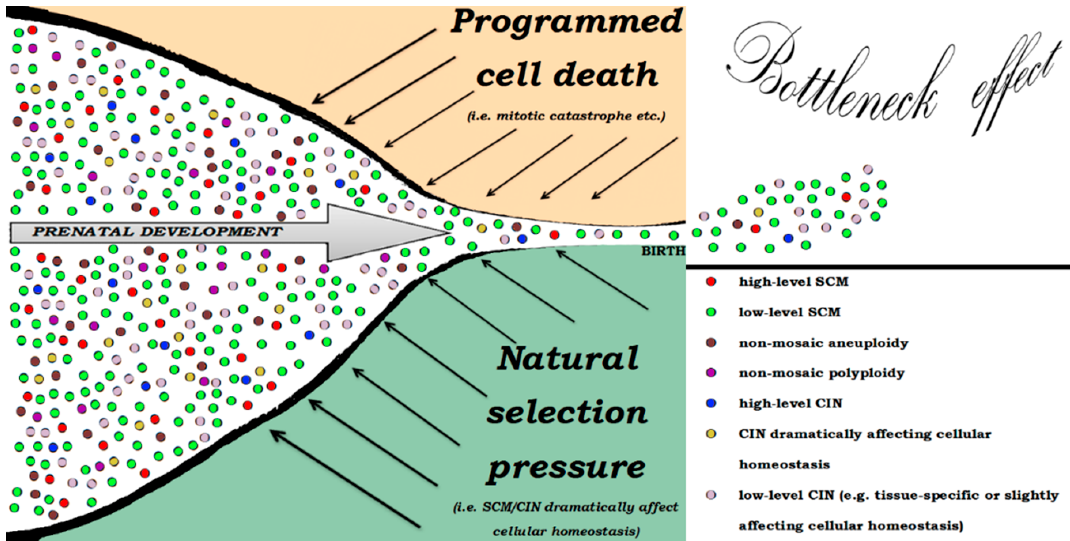
Figure 2. Schematic representation of the bottleneck model for the explanation of selective pressure in fetuses with non-mosaic chromosomal aberrations (mainly, aneuploidy, and polyploidy), SCM and CIN throughout prenatal development. The bottleneck effect may be achieved both by the natural selection pressure and by programmed cell death.